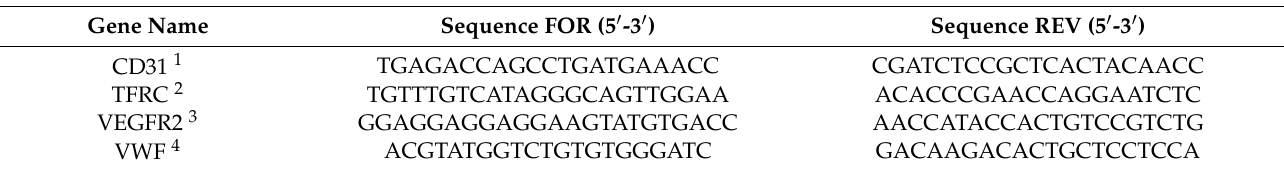
Table 2. Human-gene-specific primers used in this